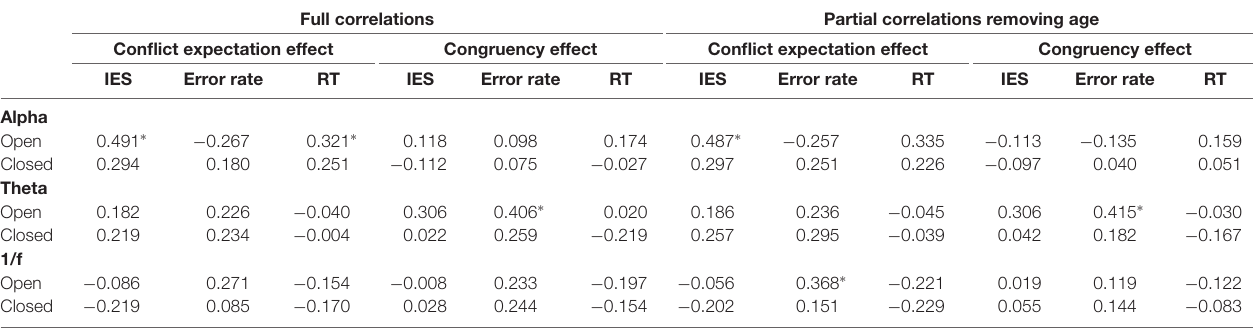
TABLE 2 | All correlations between the resting-state EEG measurements and cognitive control outcomes. Full